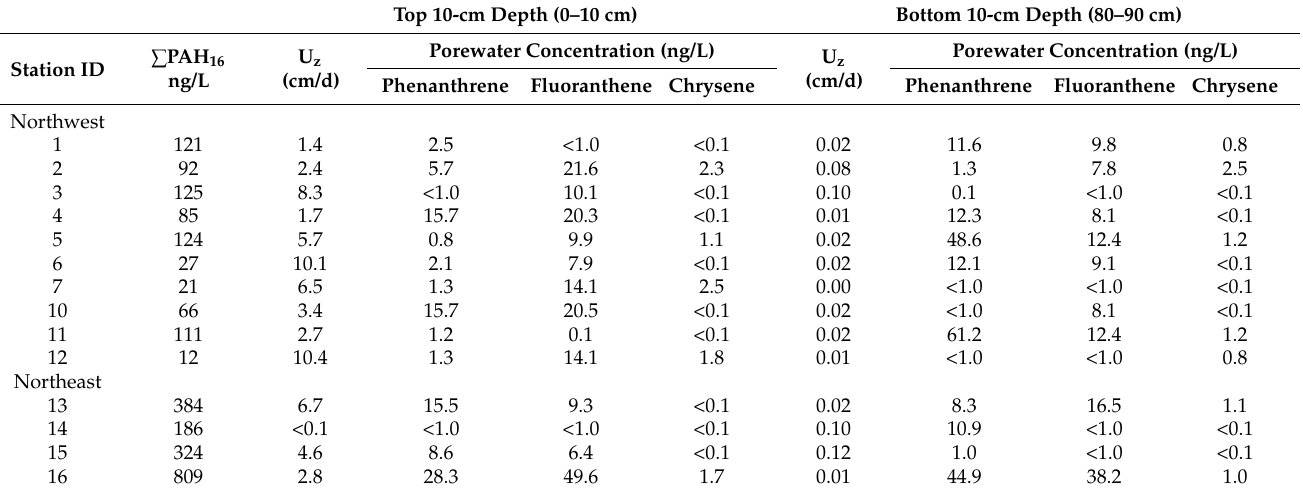
Table 2. Summary of ∑ 16 PAH averaged over depth and the concentrations for three selected PAHs in the top 10 cm and bottom 10 cm at each location sampled in 2018. Estimated velocity at each location is also included (discussed